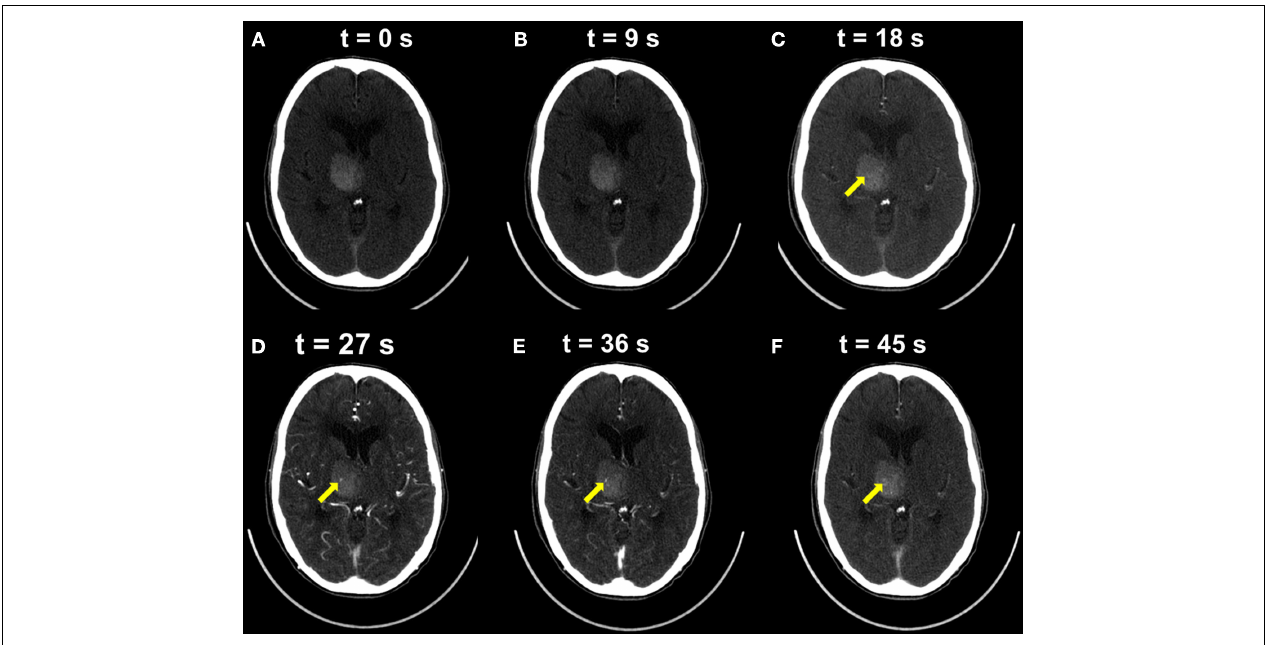
presented. (A,B) No contrast enhancement is seen within the first 9s. (C,D) At 18s early contrast is seen within a CT Spot Sign, peaking at 36s (E) . Dissipation of contrast material is seen on delayed image at 36s (F)